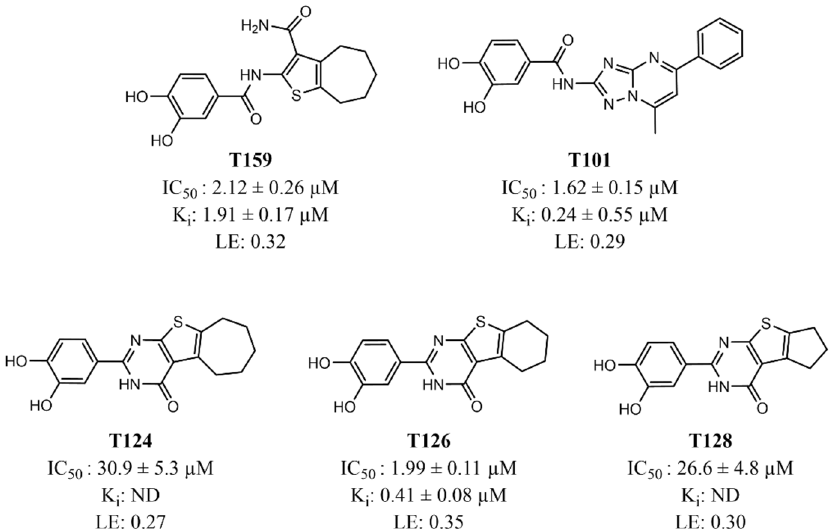
Figure 2. Chemical structure and biological data for the experimentally validated in-house com- pounds as AKT1 inhibitors. ND = not determined.